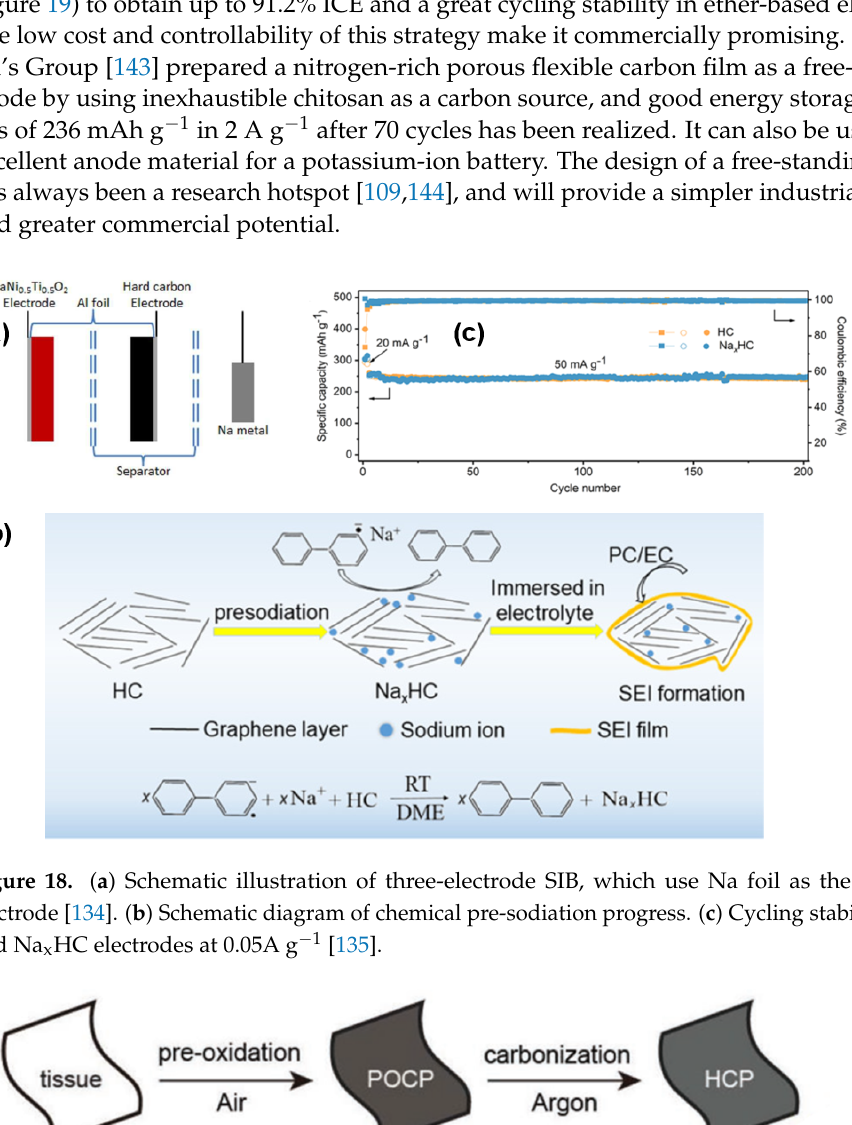
Figure 19. Schematic illustration of the preparation procedure for HC paper (HCP), and the digital photos of tissue show their flexible and self-supporting characteristics [142].